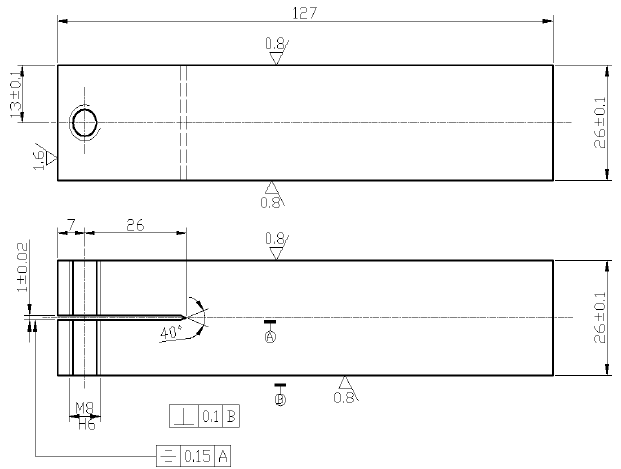
Figure 1. Dimensions in mm of DCB specimen.